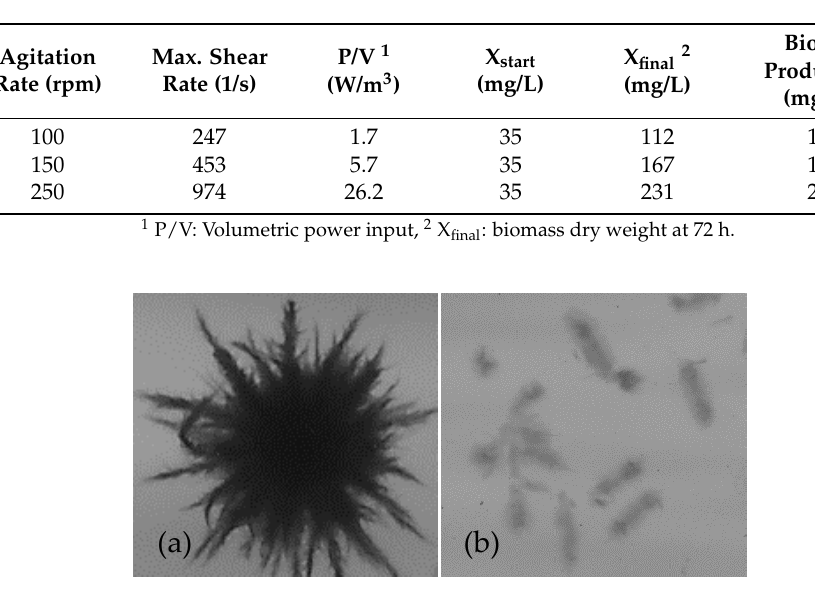
Figure 4. Shiitake pellet stained with methylene blue solution ( a ); hyphel fragments observed in fermentations ( b ).